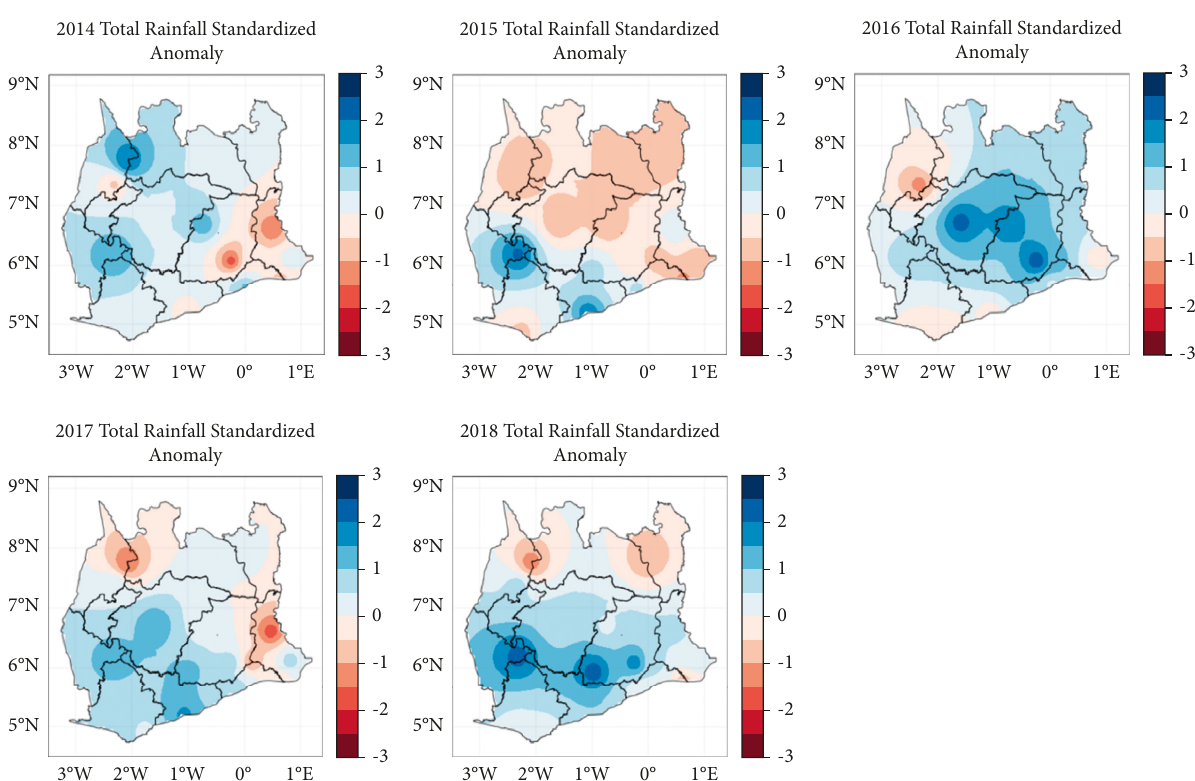
Figure 6: Spatial standardized rainfall anomaly indices for the minor season. Data used: in situ rainfall data from the Ghana Meteorological